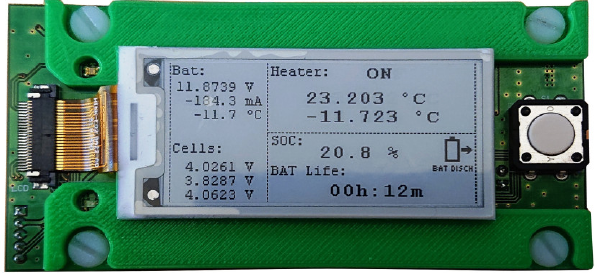
Figure 10. A prototype of the BMS system used in the switched capacitor device.